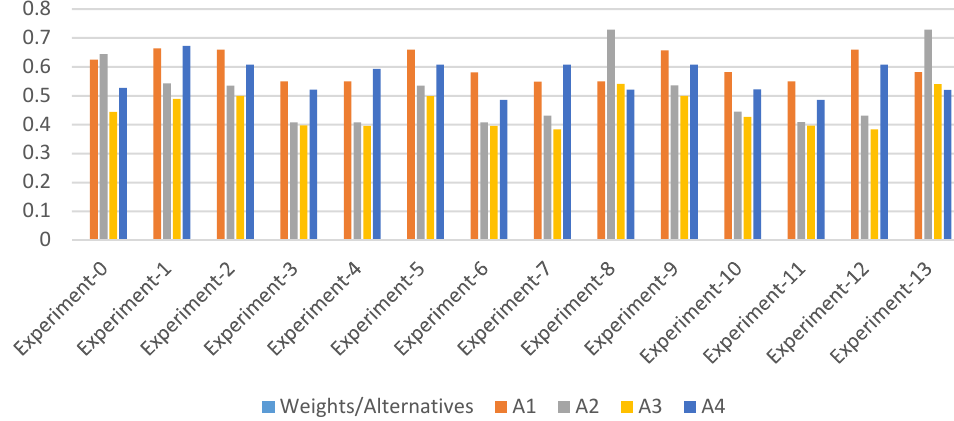
Figure 3. Graphical representation of sensitivity analysis .